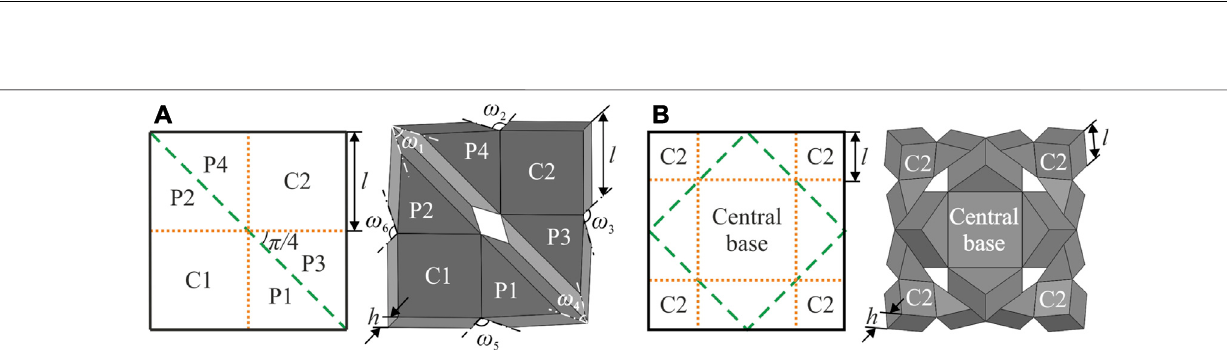
FIGURE2| Foldpatternsandcorresponding3Dkinematicmodelsof (A) asingleunitand (B) itsfour-unitassembly.Foldsontopofblocksareshownbyyellowdot lines and at the bottom by green dash lines. Four C1 blocks are patterned circumferentially to form the central base in the assembly and adjacent prisms from different units are merged.